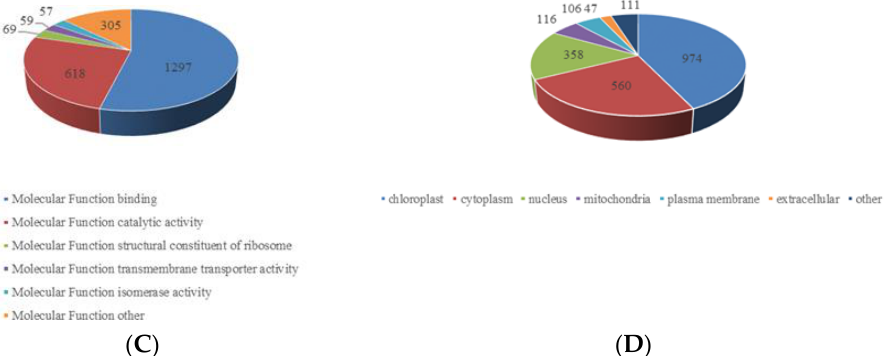
Figure 3. Gene ontology functional characterization of the identified crotonylated proteins. ( A ) Distribution of the crotonylated proteins in terms of biological processes. ( B ). Distribution of the crotonylated proteins in terms of cellular components. ( C ) Distribution of the crotonylated proteins in terms of molecular functions. ( D ) Subcellular location prediction.